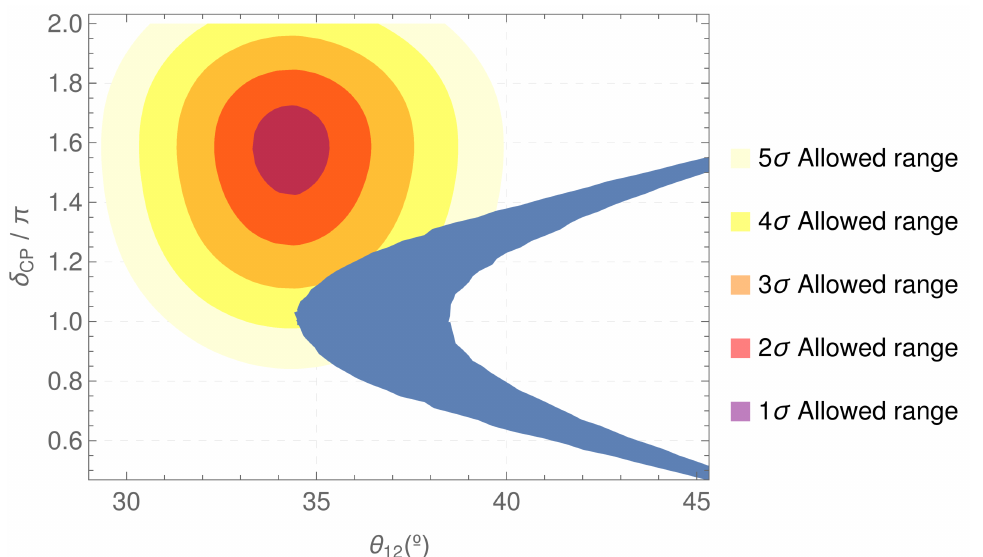
Figure 2 . Correlation between θ 12 and δ CP in the IO case when the other observables are fitted inside their 3 σ experimental ranges: charged lepton masses, neutrino squared mass differences, θ and θ . The 3 σ tension in the combined θ 23 around CP conserving values. In that case, θ extracted from the global fit